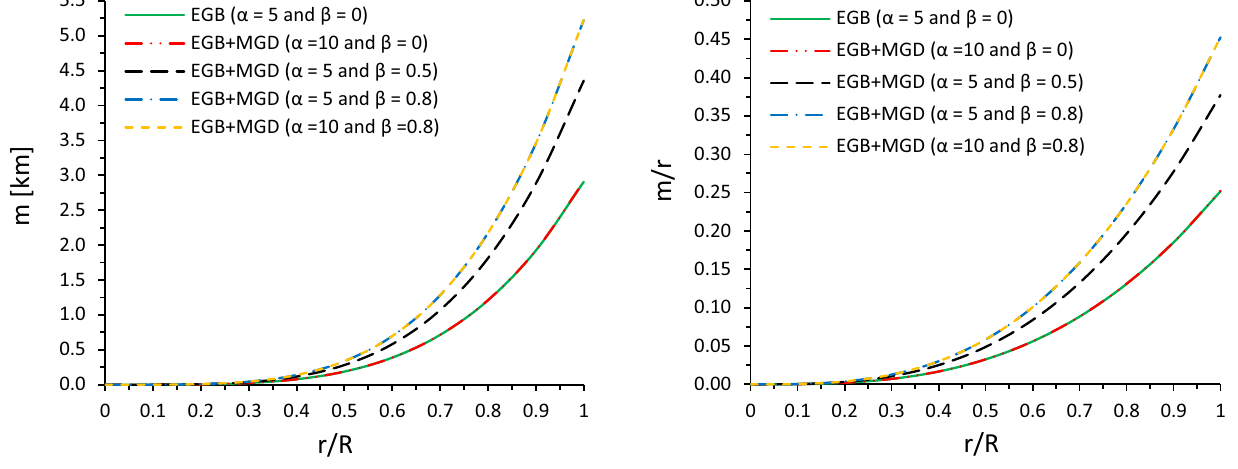
redshift function z s . We know that this quantity depends on the mass–radius ratio of the compact